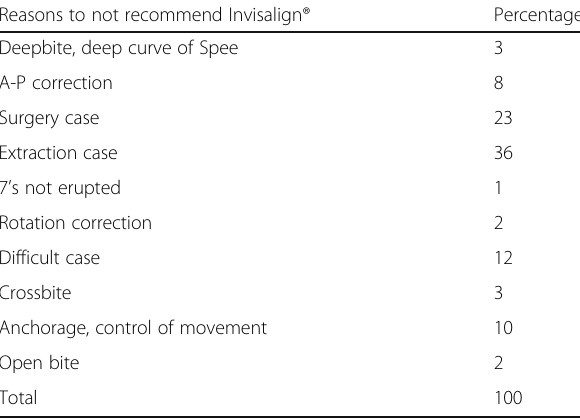
Table 6 The percentages of the reasons given for not recommending Invisalign® Reasons to not recommend Invisalign®